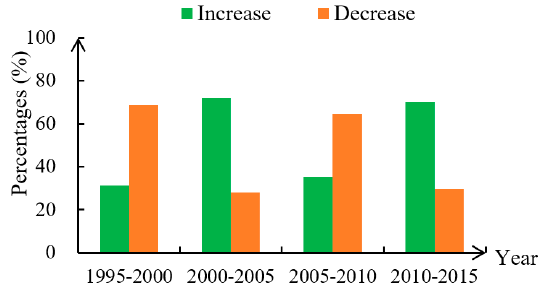
Figure 3. Changing trend of the proportion of increasing and decreasing units.